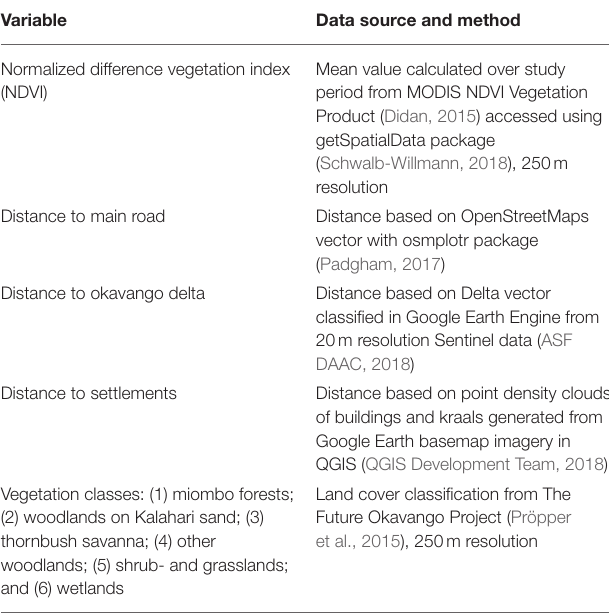
TABLE 1 | We choose the covariates below to include in our spatial models.